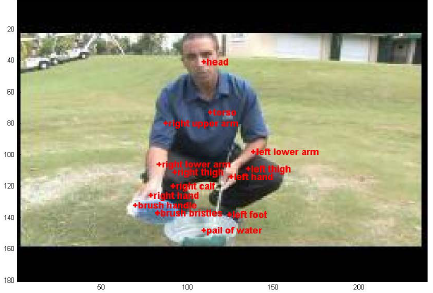
Figure 1. Frame 1000 showing object parts used in the